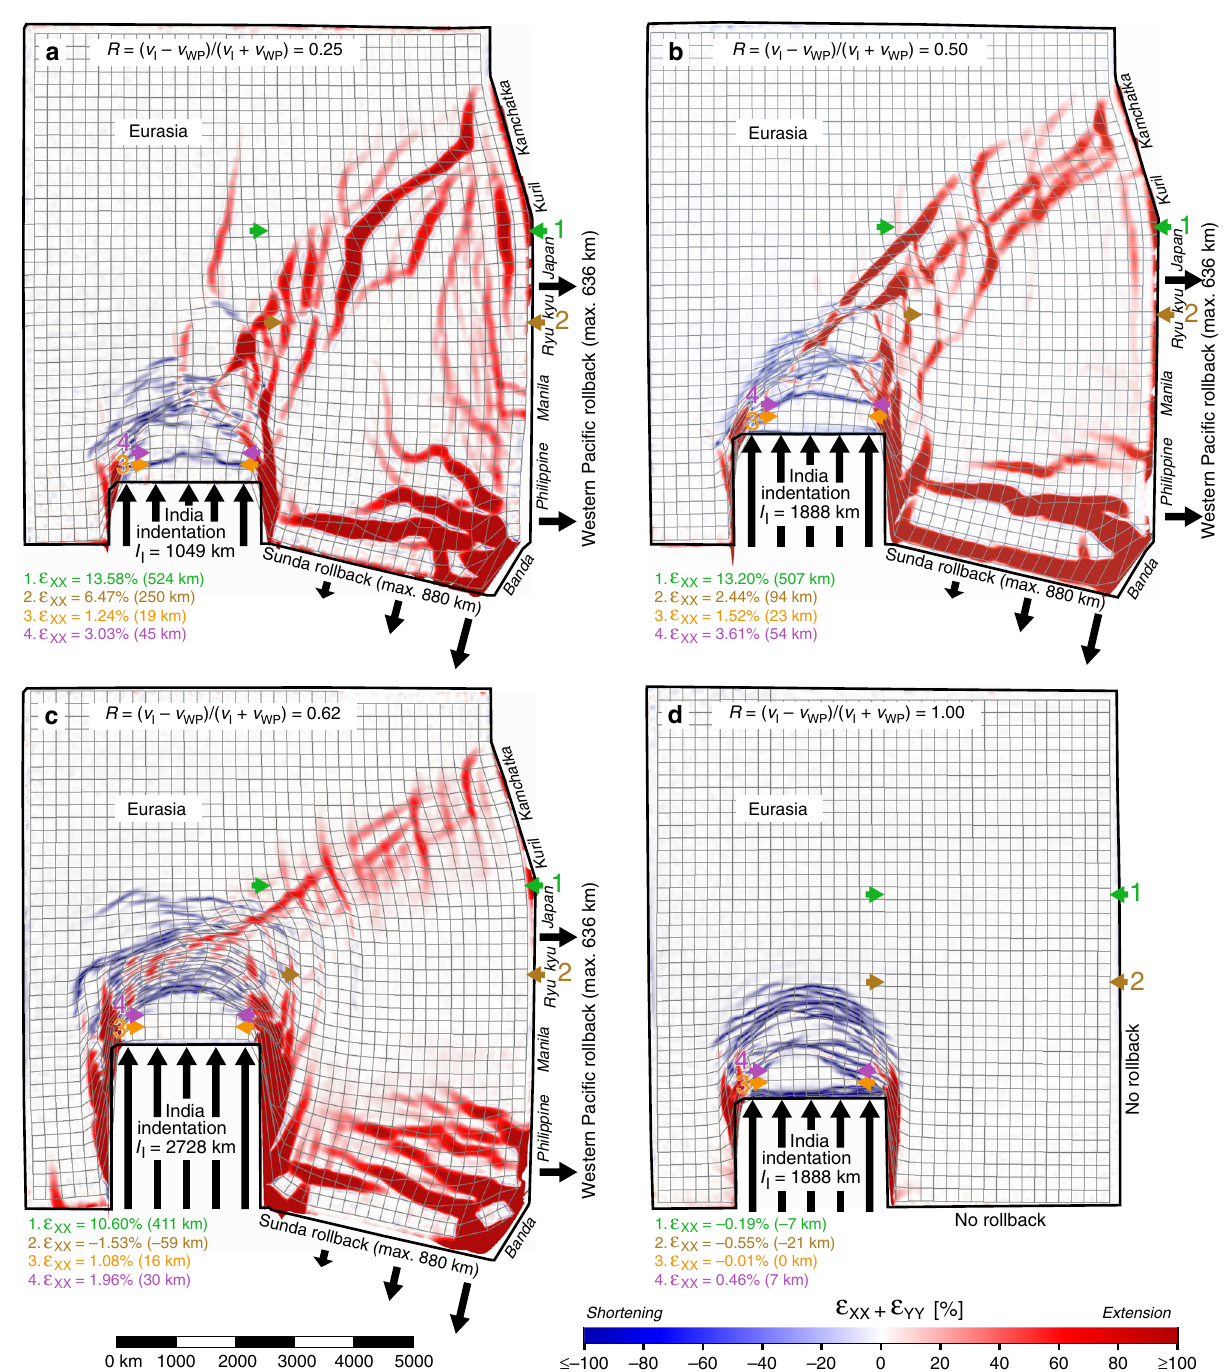
Fig. 3 Top views of four experiments with different velocity ratios showing fi nite horizontal normal strain ( ε XX + ε YY ) and deformed model grid. The experiments simulate Asian continental deformation and the velocity ratio is expressed as R = ( v I − v WP )/( v I + v WP ), where v I = Indian continental subduction hinge and slab advance (roll-forward) velocity and v WP = Paci fi c subduction hinge and slab retreat (rollback) velocity. The results are shown for the end of each experimental run. a Experiment I MIN -R with R = 0.25 (minimum indentation). b Experiment I INT -R with R = 0.50 (intermediate indentation). c Experiment I MAX -R with R = 0.62 (maximum indentation). d Experiment I INT -NR with R = 1.00 (intermediate indentation and no rollback). Note that the colour scheme indicates ε XX + ε YY . The locations of four east – west sections (1 – 4) along which east – west fi nite strain ( ε XX ) and fi nite extension are calculated are indicated with green, brown, orange and purple arrows (extension is positive, shortening is negative). These sections are the model equivalents of sections 1 – 4 shown in Fig. 1b. Experimental results showing the horizontal fi nite strain ellipse fi eld, digital photographs, horizontal fi nite displacement fi eld and surface topography are presented in Supplementary Figs. 1 – 4. Four evolutionary stages of experiments I INT -R and I MIN -R are shown in Supplementary Figs. 5 and 6,